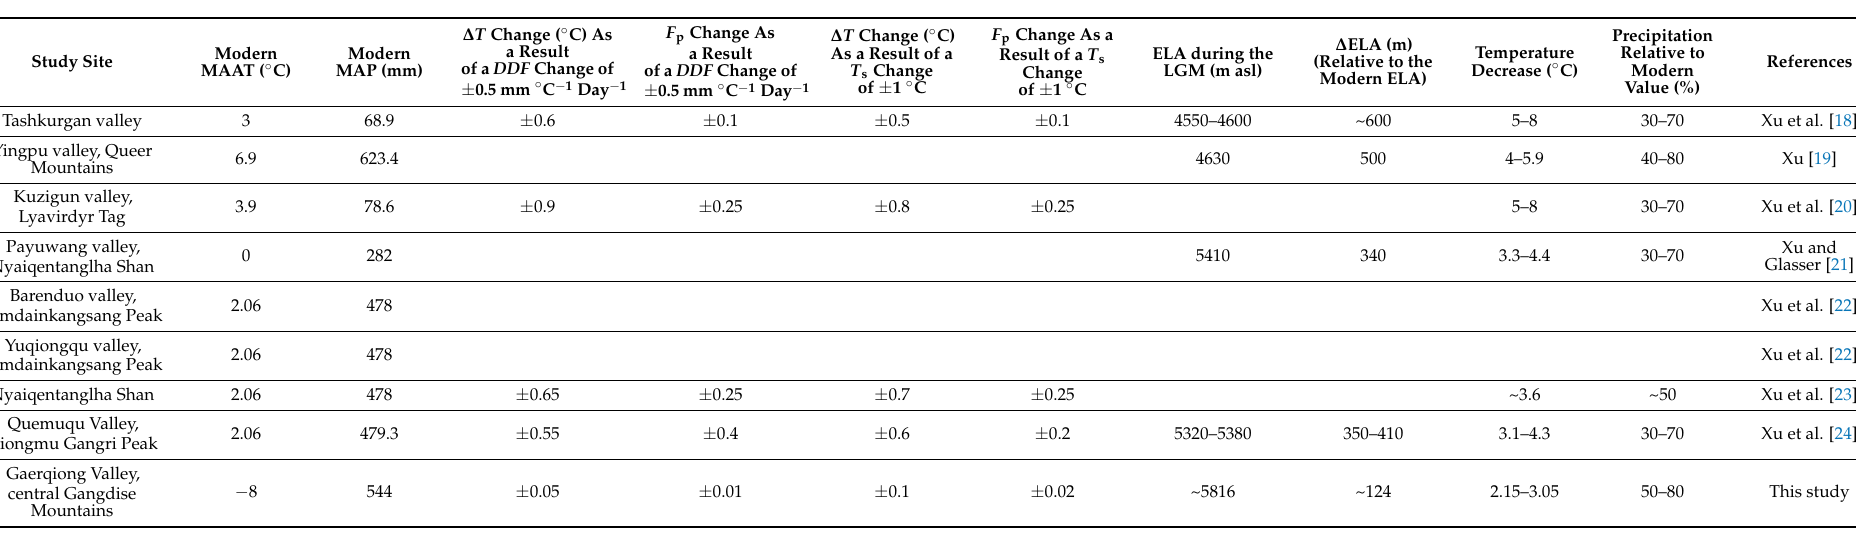
Table 1. Modern temperatures, precipitations, sensitivity tests, reconstructed equilibrium line altitudes (ELAs), temperature, and precipitation during the Last Glacial Maximum (LGM) of the study sites on the Tibetan